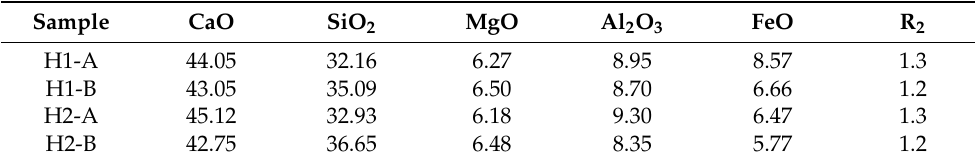
Table 4. The chemical component of the slag sample in nondropped/%.